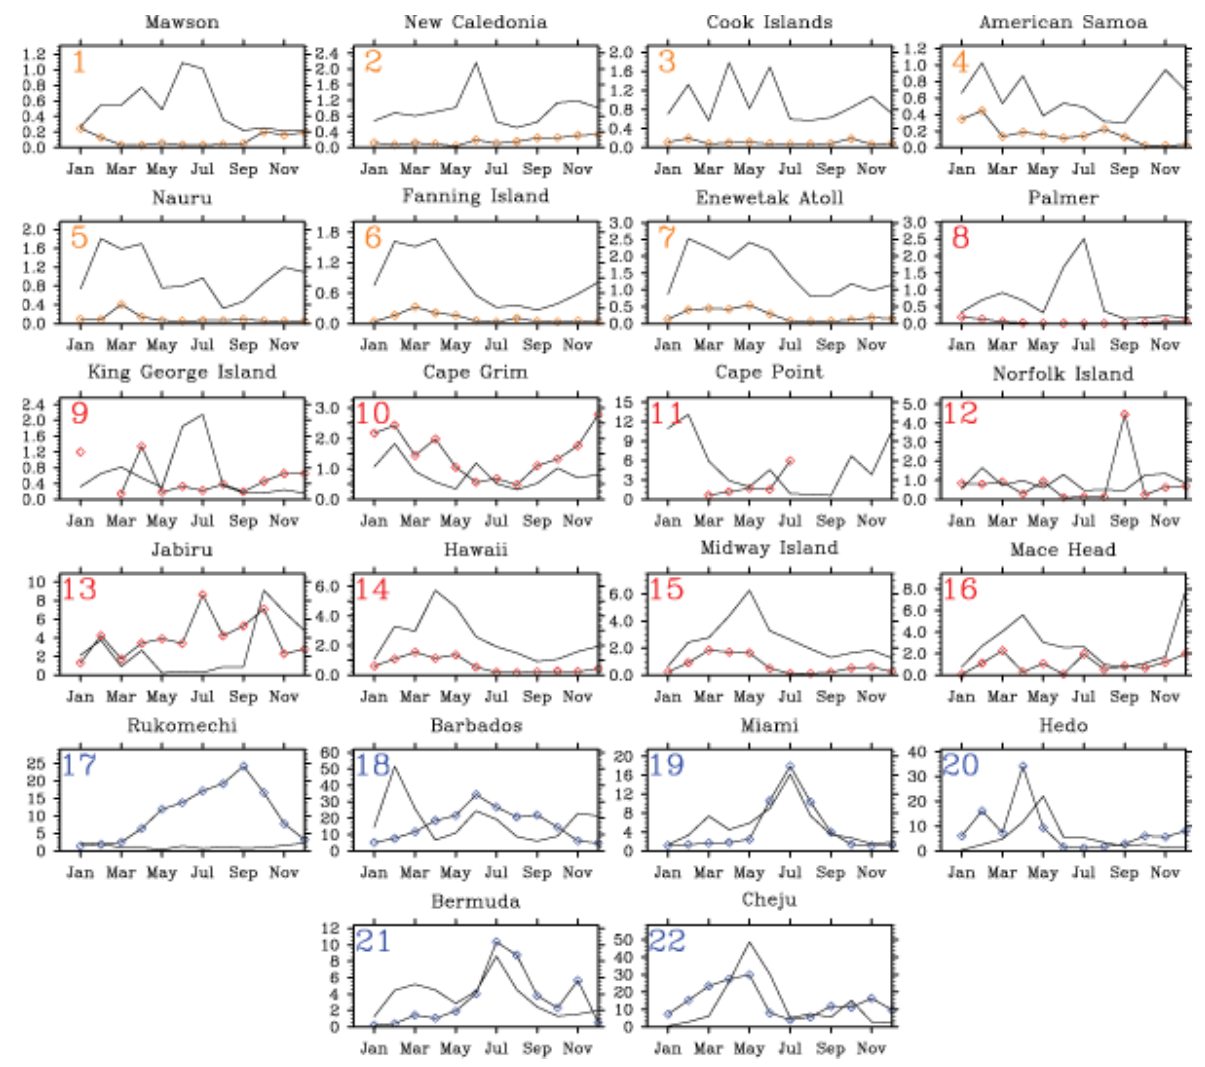
Fig. 10. Comparison for monthly mean surface dust mass concentrations (µgm − 3 ) at 22 sites from the extended University of Miami dataset. Black curves are model results from the climate run of CanAM4-PAM. Color and number in each panel are corresponding to the three groups as in Figs. 8 and 9: remote sites (orange), sites under influence of dust sources (red) and sites downwind the major dust sources (blue). Name, latitude and longitude of each site are listed in Table 6. Note that the vertical scale is different in each